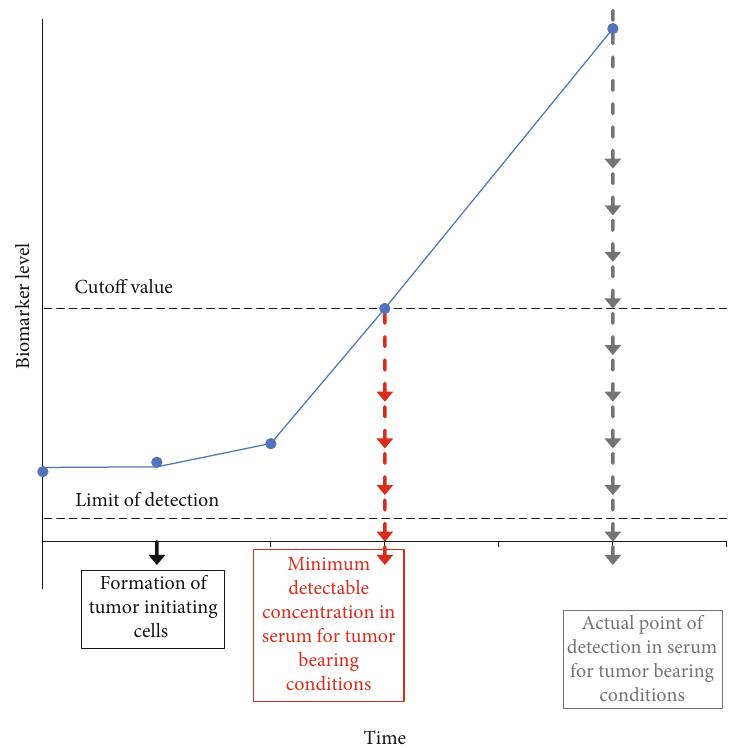
Figure 1: Minimum detectable concentration versus actual point of detection. The minimum detectable concentration (MDC) is the earliest detection point for a biomarker that exceeds its normal level of expression. As biomarkers are secreted by both healthy and tumor cells, the average biomarker level can be above the assay ’ s detection limit before tumor initiation. Therefore, a cuto ff value is required to di ff erentiate between tumor-bearing and una ff ected or benign conditions in serum assays. As tumor size increases, biomarker expression increases (blue circles). Although a biomarker is detected at or below the cuto ff value, samples are not considered diseased until they exceed this cuto ff value (the actual point of